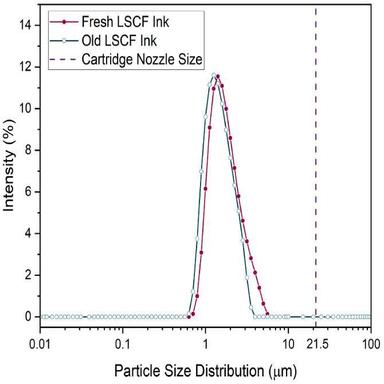
Particle size distribution of fresh and old LSCF electrode inks. D50 for fresh and old LSCF inks are 1.58 μm and 1.49 μm, respectively.